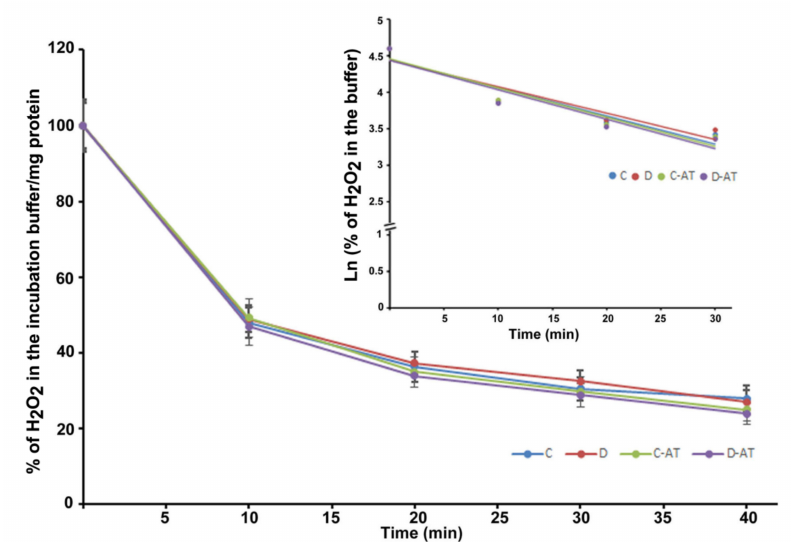
Figure 2. Clearance of H 2 O 2 by the 5 weeks excised control and diabetic retina under euglycemic and hyperglycemic incubation conditions. Control retinas were incubated in the buffer with 5 mM glucose ± 3-aminotriazole (3-AT), and diabetic retinas with the buffer containing 20 mM glucose ± 3-AT. The retinas were pre-incubated for 30 min in the incubation buffer with or without 3-AT. Clearance reactions by the retinas started with the addition of 5 µ M H 2 O 2 . Insert: semi-logarithmic representation of the data obtained during the 30 min period. The half-lives are approximately 14 and 15 min, in the control and diabetic retina, respectively. No significant change in the rate of disposal was observed in the case of 3-AT treatments in both control and diabetic retinas. The content of the retinal protein was determined for each incubation. Values are means ± SEM for 5 determinations (n = 5 for each). (C) control; (D) diabetic; AT (aminotriazole).